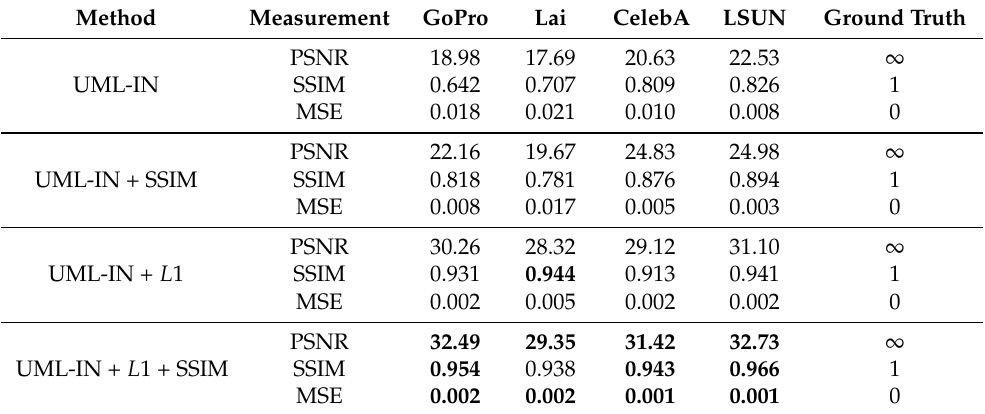
Table 2. Quantitative comparisons evaluated on different datasets with different methods. The best measurements for each of the datasets are in